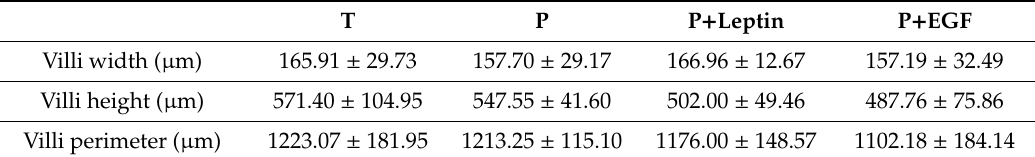
Table 3. Histomorphometric variables of the small intestine: villi widths, heights, and perimeters from the four groups: Term (T), Preterm (P), P + Leptin, and P + epidermal growth factor (P + EGF) at day 10 of suckling period.